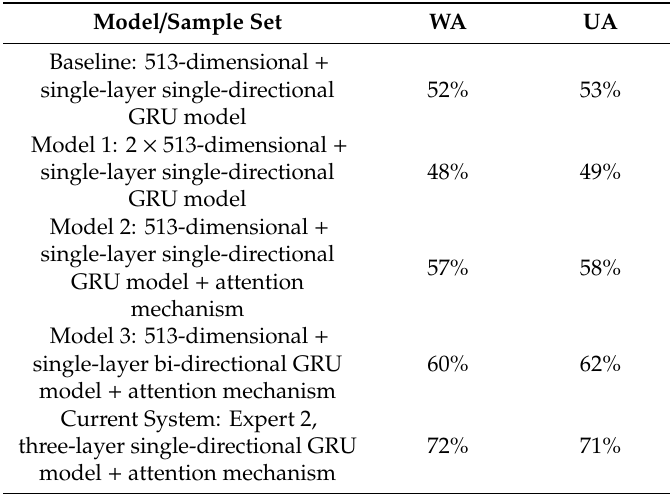
Table 3. Test results of expert 2.